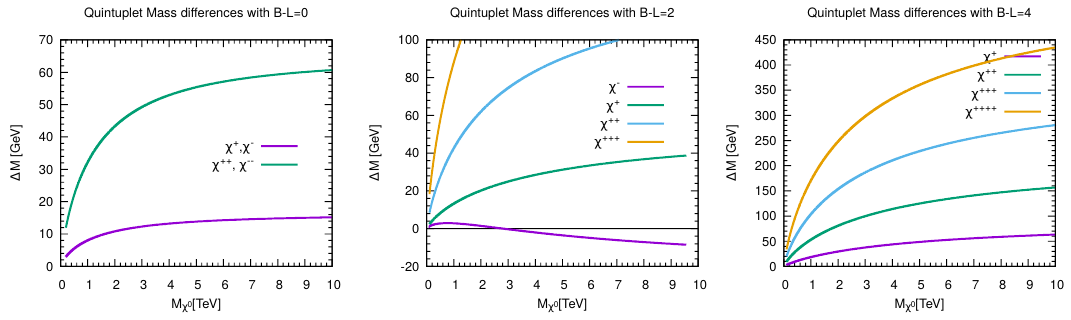
Figure 1 . Mass di(cid:11)erence between various charged states as a function of the neutral state mass for di(cid:11)erent B-L cases for M W = 6 TeV and M Z = 7 : 14 TeV. Note that the y-axis ranges are R R di(cid:11)erent in all the